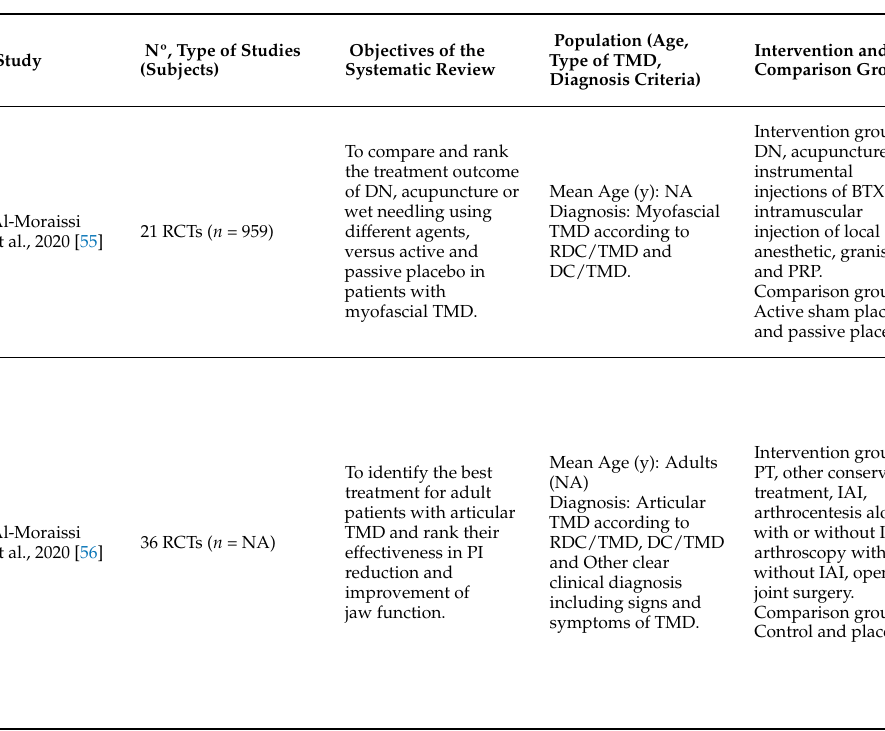
Table 1. Characteristics of the included systematic